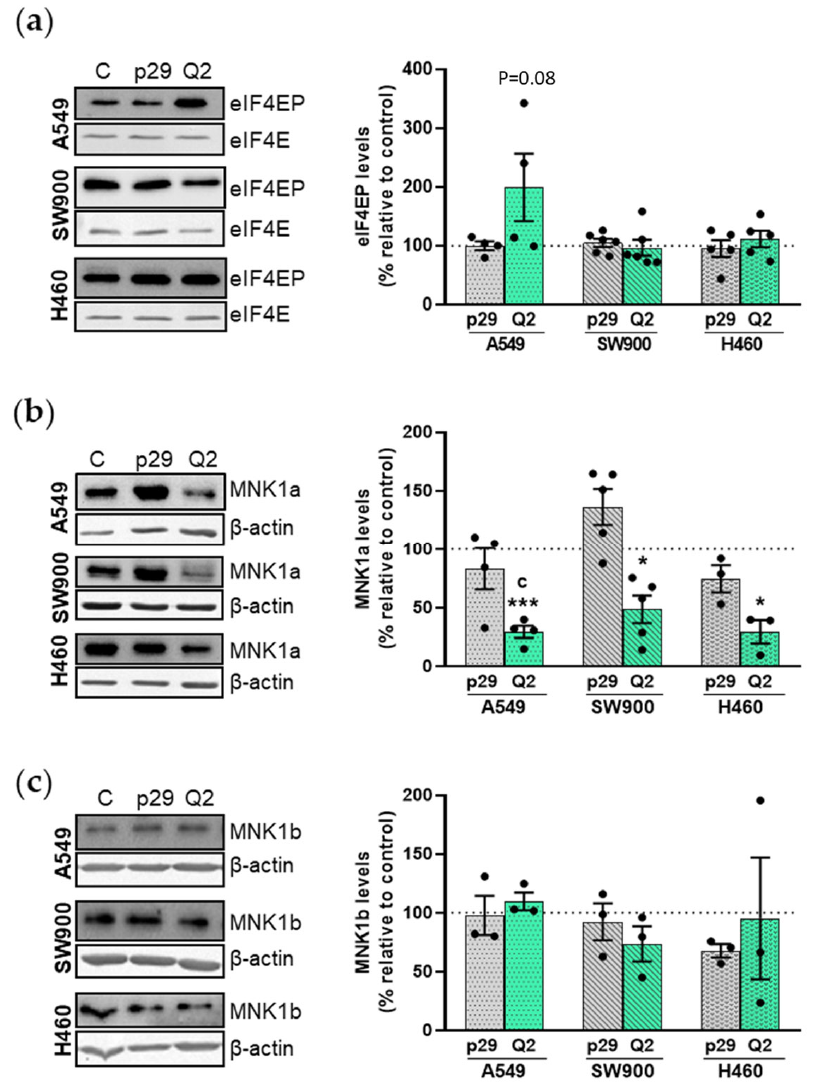
Figure 5. Effect of apMNKQ2 on eIF4E phosphorylation and MNK1 isoforms. Lysates (20 µ g) were subjected to SDS-PAGE (12%) and western blotting was performed using specific antibodies (see Supplementary Table S1). Actin detection was used as a loading control. A representative blot and corresponding densitometry analyses are shown in each figure. ( a ) Quantification of eIF4EP was normalized to total eIF4E levels and expressed as a percentage relative to control (C) cells ( b ) and ( c ) quantification of MNK1a/b was normalized to β -actin levels and expressed as a percentage relative to control cells. The graphs represent mean values ± SEM of 3–5 independent experiments. * p < 0.05 and *** p < 0.001 relative to control cells; c p < 0.05 relative to p29 control. Control is shown as C, p29 is the unspecific aptamer used as a negative control, and apMNKQ2 is shown as Q2. Each solid black circle represents one individual